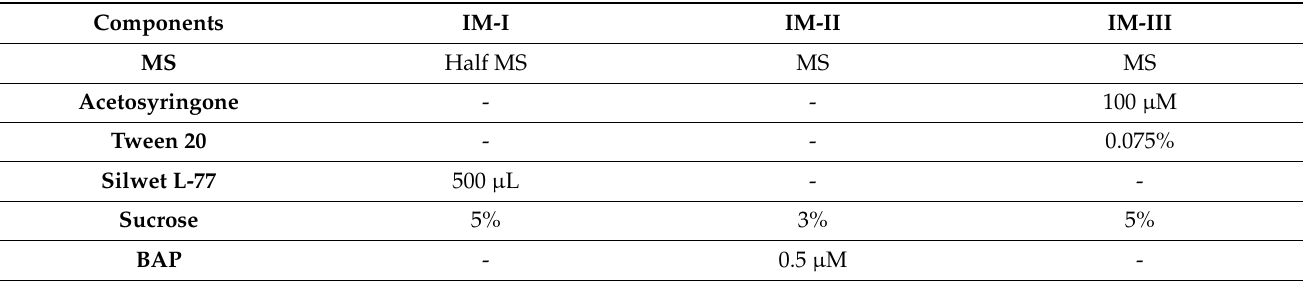
Figure 5. Screening for transgenics. ( a ) PCR conformation of visually screened plants (Transformed ones, -ve control, +ve control), ( b ) GUS histochemical assay of the identified positives (Bar = 1 inch), and ( c , d ) the bar graph comparison of the different variables (IM: Induction medium, T: Cocultivation time, and S: Flower stage). Table 2. Composition of the IM used in the